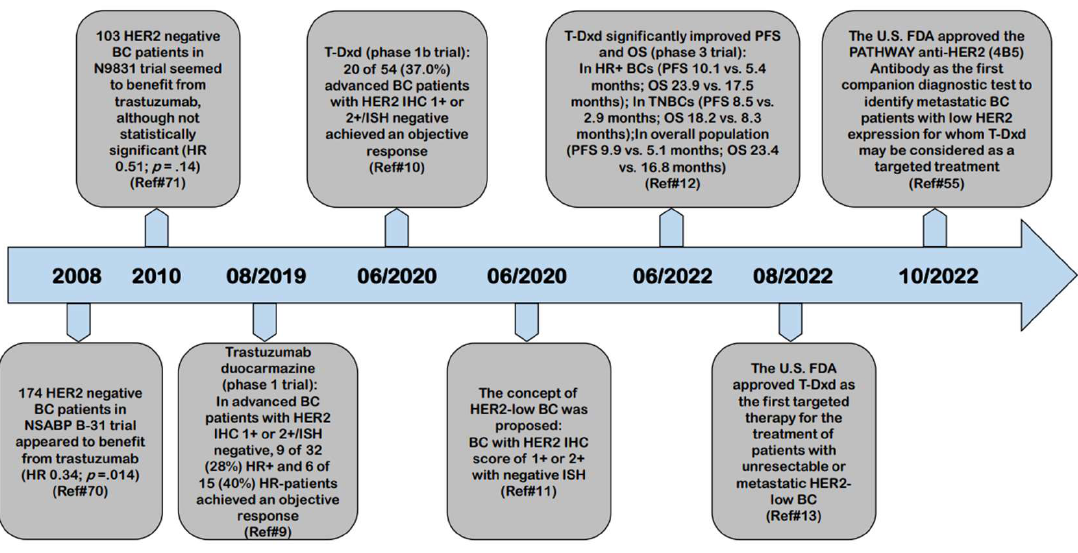
Figure 2. Key publications and timeline in the natural history of HER2-low BC. BC: Breast cancer; DFS: Disease-free survival; FDA: Food and Drug Administration; HER2: Human epidermal growth factor receptor 2; HR: Hazard ratio; HR: Hormonal receptor; IHC: Immunohistochemistry; ISH: In situ hybridization; OS: Overall survival; PFS: Progression-free survival; T-Dxd: Trastuzumab deruxtecan; TNBC: Triple negative breast cancer.